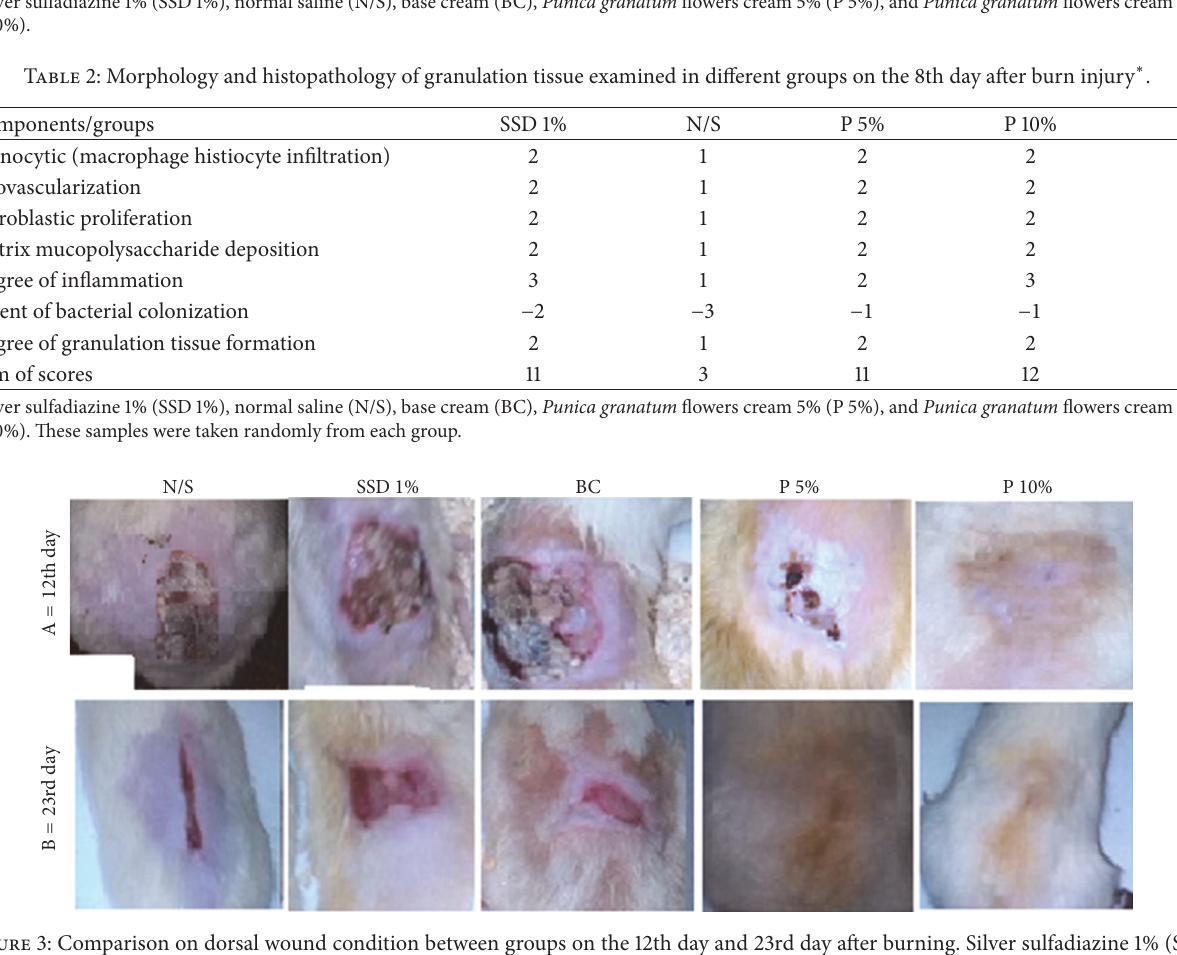
Figure 3: Comparison on dorsal wound condition between groups on the 12th day and 23rd day after burning. Silver sulfadiazine 1% (SSD 1%), normal saline (N/S), base cream (BC), Punica granatum flowers cream 5% (P 5%), and Punica granatum flowers cream 10% (P 10% in A = on the 12th day and B = on the 23rd day after burn